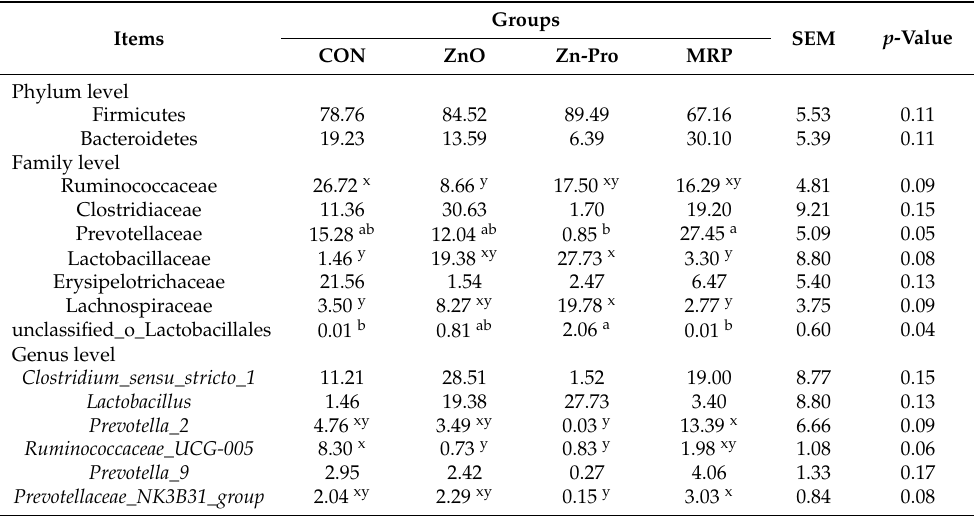
Figure 1. Microbial α -diversity in the feces of weaned pigs on d 28 of experiment. ( A ) Ace index. ( B ) Chao index. ( C ) Shannon index. CON, a basal diet without any Zn source addition; ZnO, basal diet + 1600 mg Zn/kg from zinc oxide; Zn-Pro, basal diet + 60 mg Zn/kg from Zn-Pro; MRP, basal diet + 800 mg/kg MRF + 60 mg Zn/kg from Zn-Pro. Table 7. Effects of different treatments on the relative abundance of main microbiota in colonic digesta of weaned piglets on d 28 of experiment.